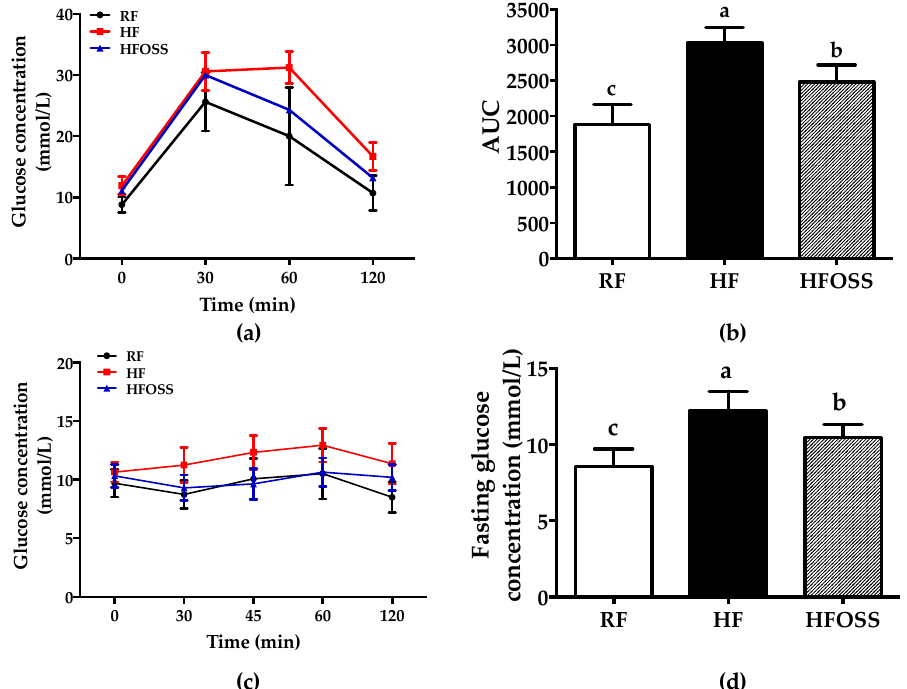
Figure 2. Glucose and insulin tolerance of mice fed a regular-fat (RF) diet, high-fat (HF) diet, and high-fat diet supplemented with OS starch (HFOSS). ( a ) Blood glucose response of mice under intraperitoneal glucose tolerance test (IPGTT); ( b ) area under the curve (AUC) of the IPGTT; ( c ) blood glucose response of mice under insulin tolerance test (ITT); ( d ) fasting blood glucose concentration of mice. Values with different letters indicate significant differences between groups ( p < 0.05).